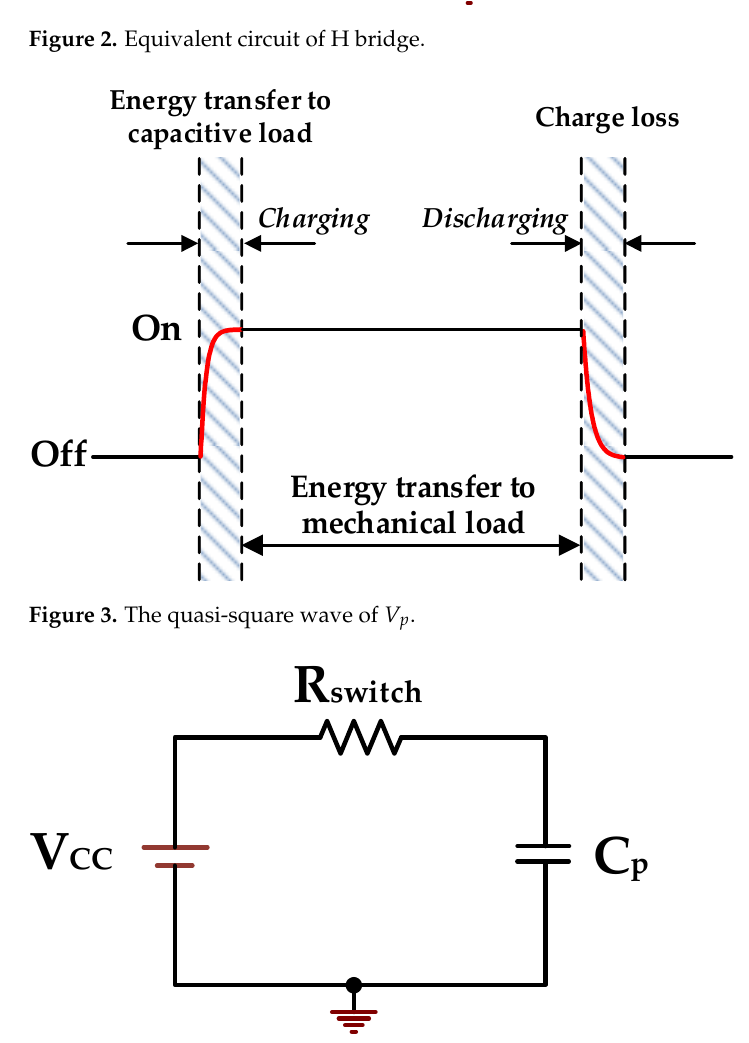
Figure 4. Equivalent RC circuit for charging.